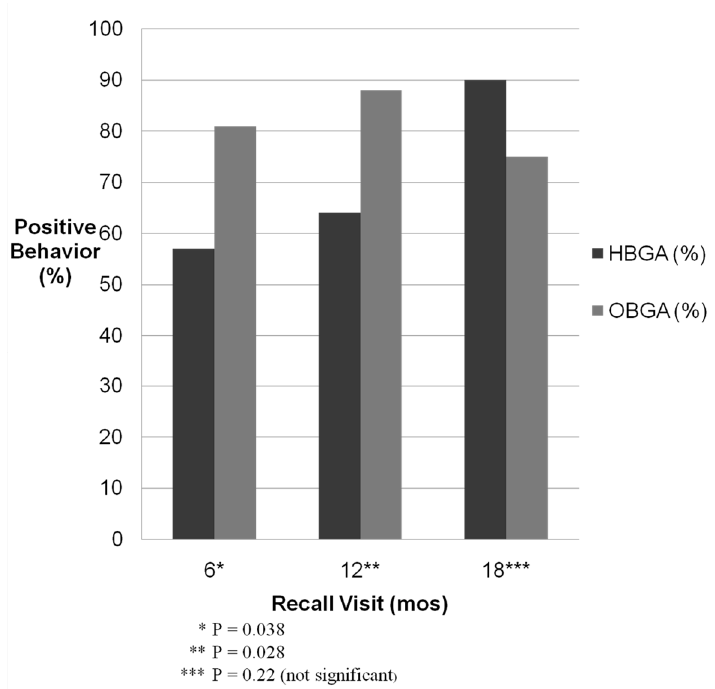
Figure 1. Percentage of postive behavior at follow up visits.